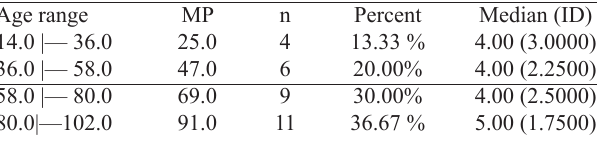
Table 3. Distribution of, and the number of, valves per age group. Age range 14.0 |— 36.0 36.0 |— 58.0 58.0 |— 80.0 MP=Midpoint of the sample; n=Frequency; ID=Interqualitic deviation (DIQ) of the